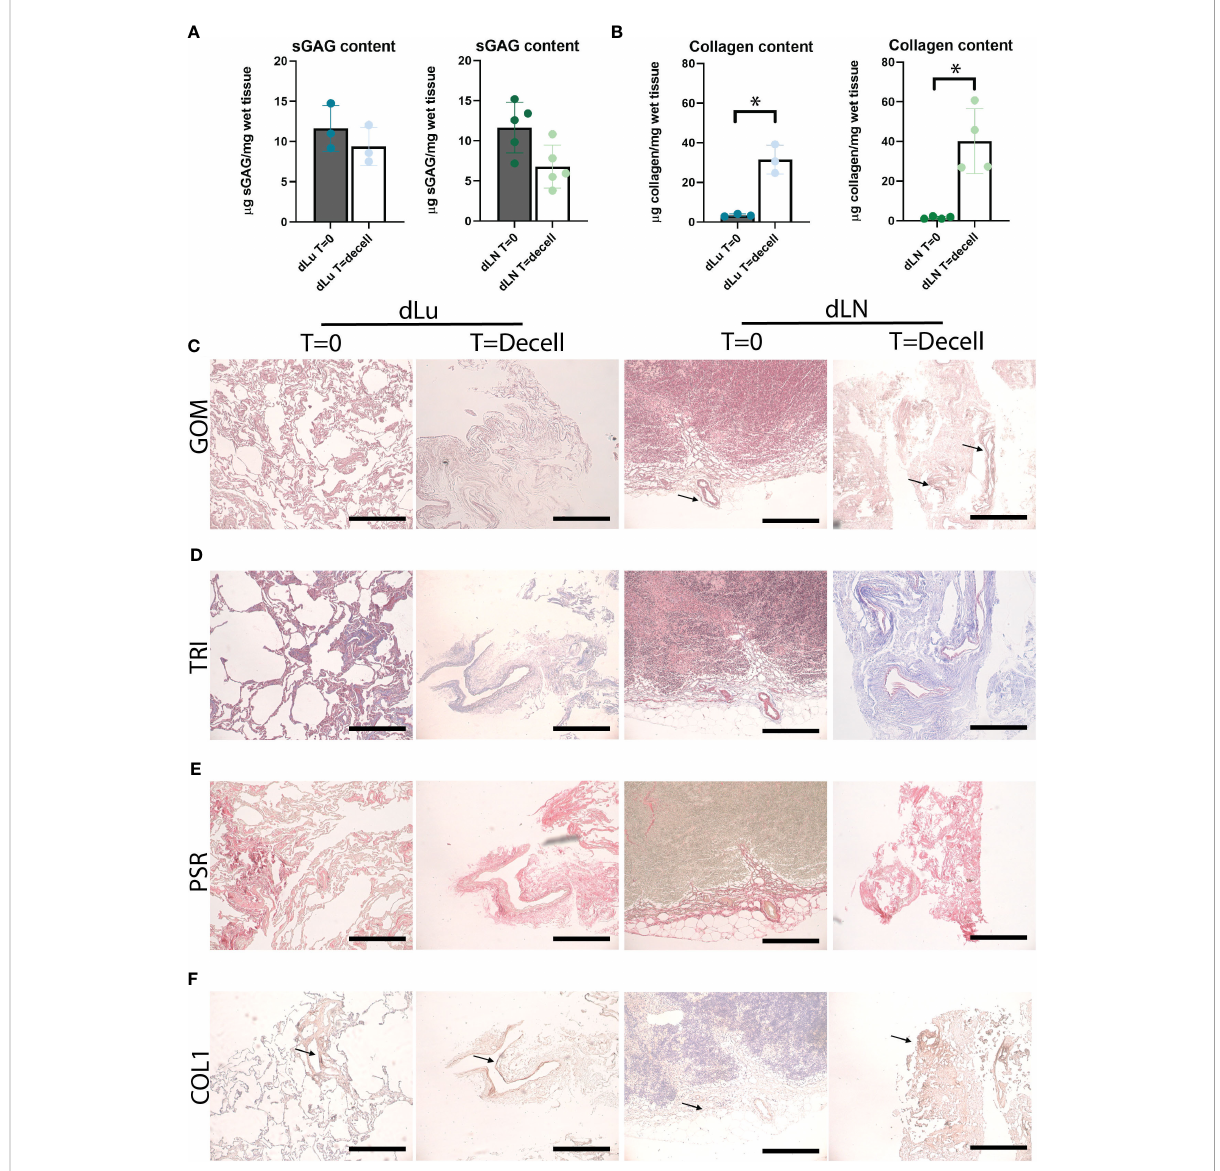
FIGURE 2 Preservation of ECM proteins after decellularization of human lung and lymph node. (A) Quantitative sGAG content analysis of lung (n=3, p=0.5) and lymph node (n=5, p=0.07) before and after decellularization showing retention of sGAG. dLu1, 2, 3 and dLN17, 27, 7, 10, 11 were used. (B) Quantitative collagen content analysis of lung (n=3, p=0.02) and lymph node (n=4, p=0.02) before and after decellularization, showing retention of collagen. dLu1, 2, 3 and dLN2, 4, 7, 15 were used. Paired t-tests were used for determining signi fi cance for determining signi fi cance in sGAG and collagen content. *= p-value <0.05. (C – E) Lung (dLu1) and lymph node (dLN12) before (T=0) and after (T=decell) decellularization stained with Gomori ’ s (GOM, C ), Masson ’ s Trichrome (TRI, D ) and PicroSirius Red (PSR, E ) shows ECM architecture primarily consisting of collagen fi bers. GOM shows reticulin (black), nuclei (red), and cytoplasm (pink). TRI shows muscle (red), collagen (blue), nuclei (brown/black), cytoplasm (brick red). (F) Representative images of collagen type 1 staining of lung (dLu1) and lymph node (dLN1) before and after decellularization. All scale bars indicate 200